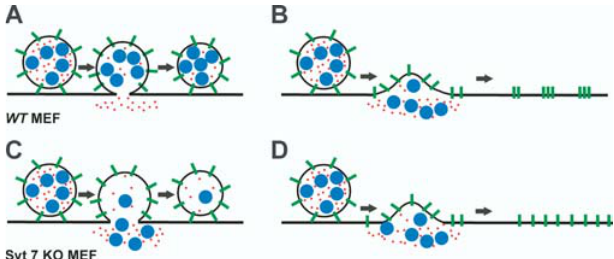
Figure 4. Schematic Representation of the Fate of Lumenal and Membrane Cargo during Lysosomal Exocytosis (A) Partial fusion of the lysosomes from WT MEFs result in the release of a fraction of the smaller (70–250 kDa; red circles) dextran, but no release of the larger (500 kDa; blue circles) dextran. None of the lysosomal membrane protein (green bars) is delivered to the plasma membrane. (B) Complete fusion leads to release of both the large and the small dextrans and delivery of the membrane proteins to the plasma membrane, but the proteins aggregate in small puncta near the site of fusion. (C) Knockout of Syt VII causes larger-sized dextran to be released even during partial fusion, and the membrane protein is still not delivered to the plasma membrane. (D) During complete fusion, both sized dextrans are released completely and the membrane proteins delivered to plasma membrane are free to diffuse away from the site of fusion. DOI: 10.1371/journal.pbio.0020233.g004